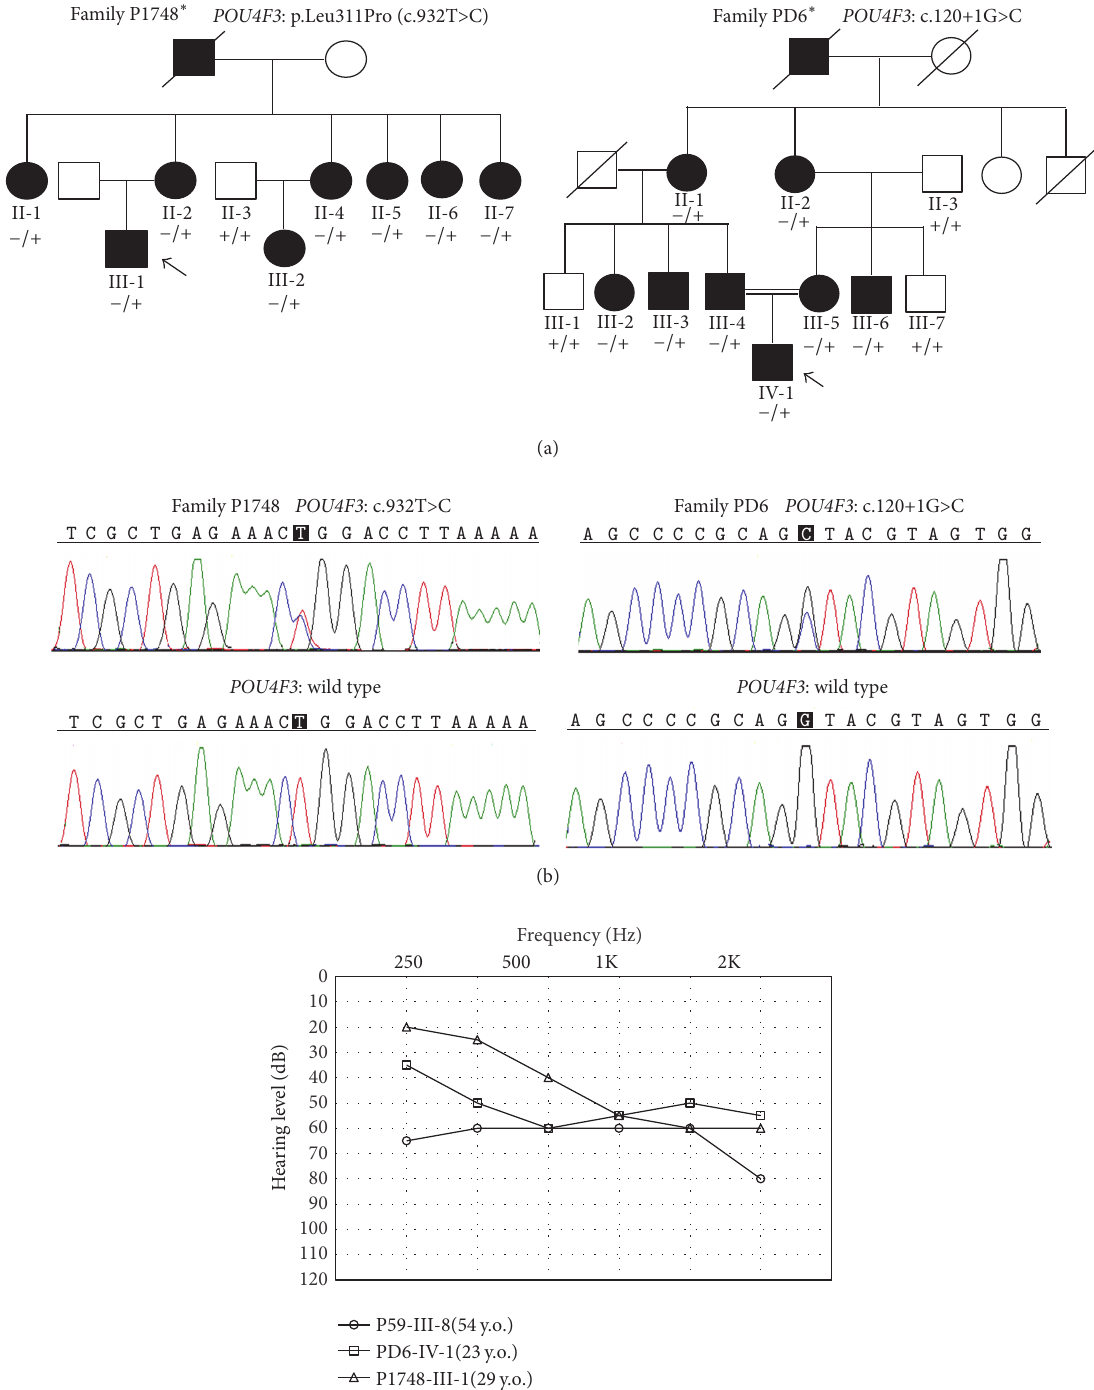
Figure 1: POU4F3 mutations identified in the Chinese Han ADNSHL families. (a) Pedigrees and genotypes of the families with POU4F3 mutations.Probandswerepointedbyarrows. − and+indicatethemutantandwildtypealleles,respectively.Asterisksindicatethefamilieswith POU4F3 mutations identified in the present study. (b) Chromatograms showing the c.932T > C (p.Leu311Pro) and the c.120+1G > C mutations in POU4F3 . (c) Audiograms of the probands of the three